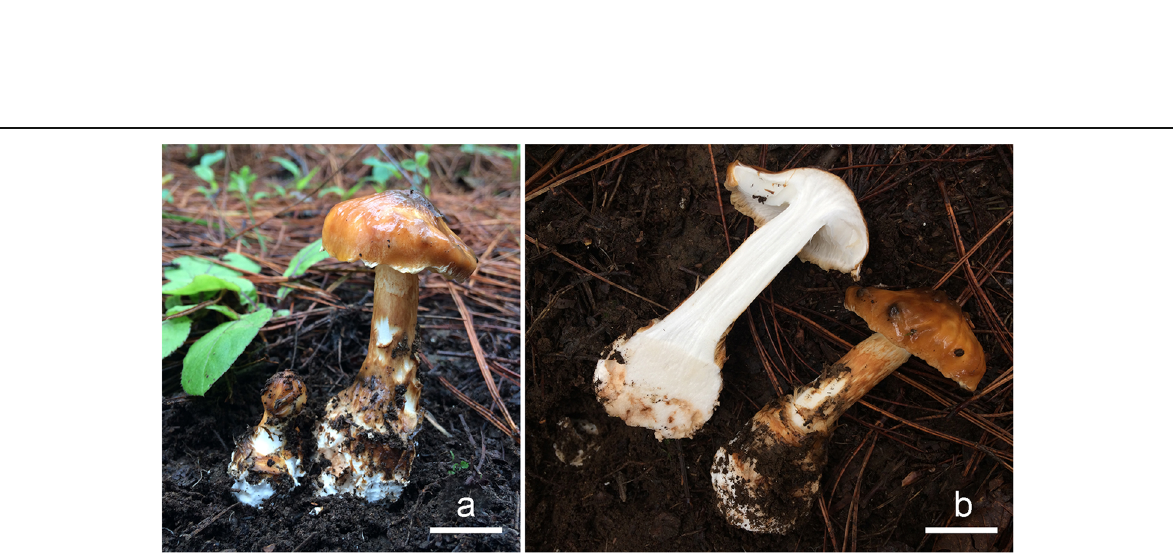
Fig. 10 Microscopic features of volval remnants on the pileus of Amanita sepiacea (HKAS32519) and Squamanita orientalis (HKAS74862A, holotype). a the upper part of a volval remnant on the pileus of A . sepiacea . b the lower part of a volval remnant on the pileus of A . sepiacea . Drawings by Zhuliang Yang (2005). c Upper layer of a volval remnant on the pileus of S. orientalis . d Inner layer of a volval remnant on the pileus of S. orientalis . Drawings by Jianwei Liu. Bars = 20 μ m. Cells with vacuolar pigment and vascular hyphae are dotted and shaded respectively. Hyphae with clamps belong to S. orientalis